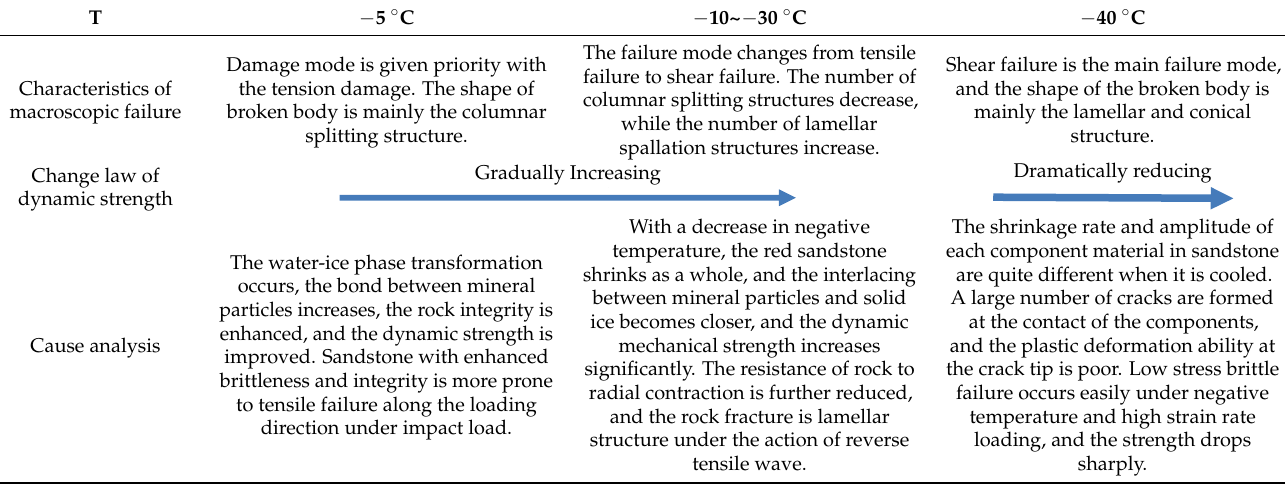
Table 3. Macroscopic failure characteristics of red sandstone at different temperatures.